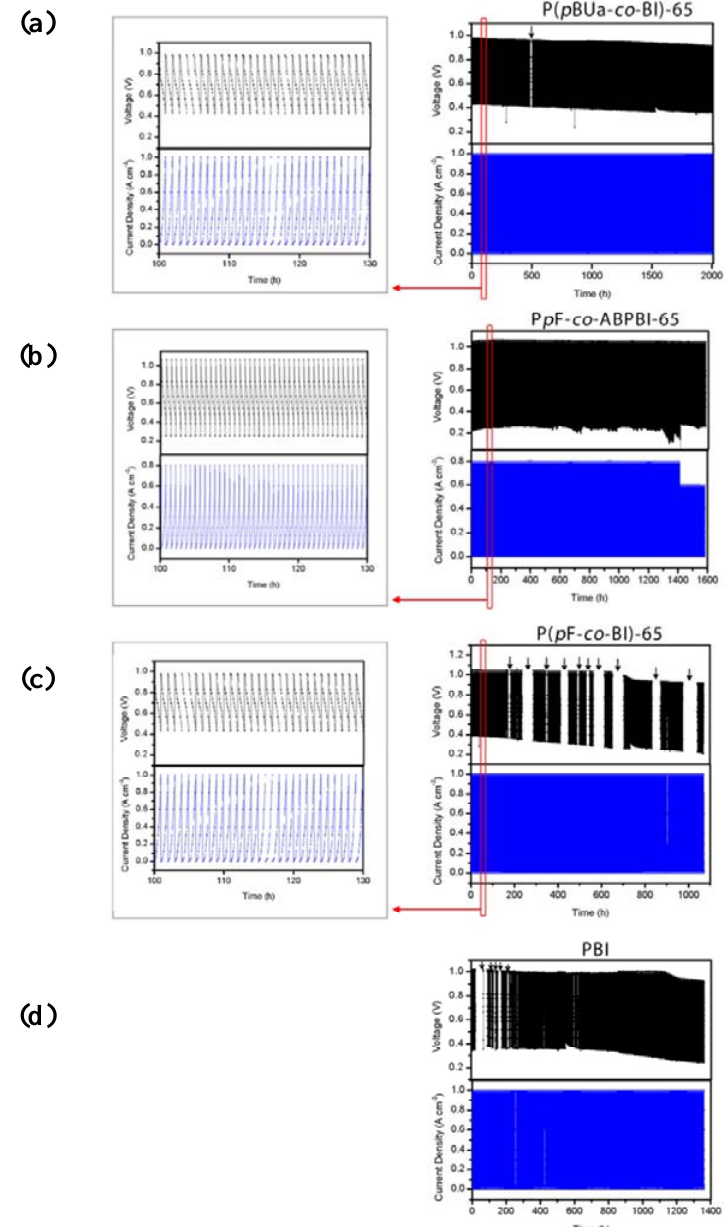
8. In situ acceleration lifetime test (ALT) of ( a ) P( p BUa- co -BI)-65; ( b ) P p F- co -ABPBI-65; ( c ) P( p F- co -BI)-65 and ( d ) PBI membranes at 150 °C, in and air, cathode; 0.9 mg cm − 2 PtRu loading, anode; non-humidified H 2 1.7 mg cm − 2 PtCo loading. The active area is 7.84 cm 2 . Downward arrows (0.9 in the figure denote the regions induced by temporary recording